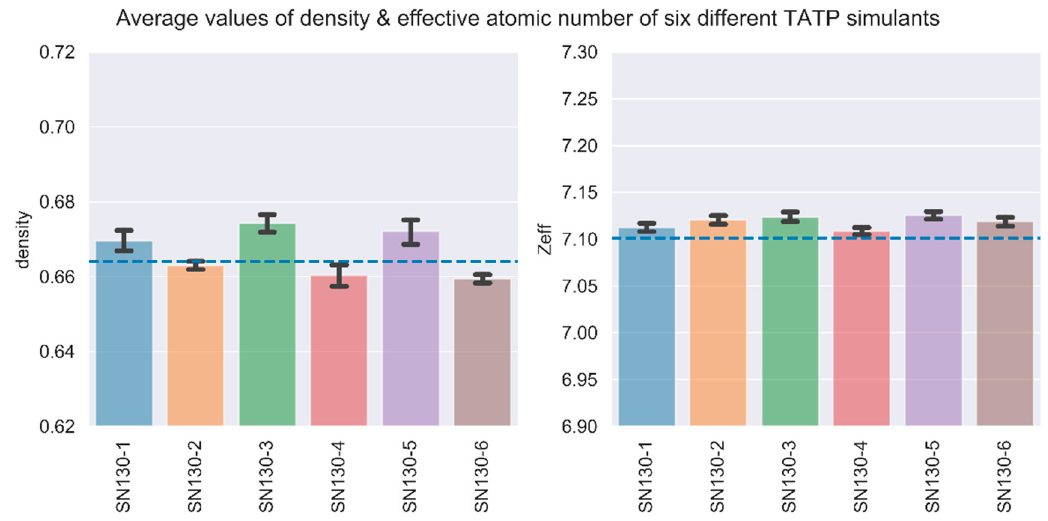
Figure 3. Density and effective atomic number of six TATP simulants. The bars indicate the mean of 60 runs per simulant (over four different days), and the error bars indicate the 95% confidence intervals. The dashed lines show the target values of the real TATP: density = 0.66, Zeff = 7.10.